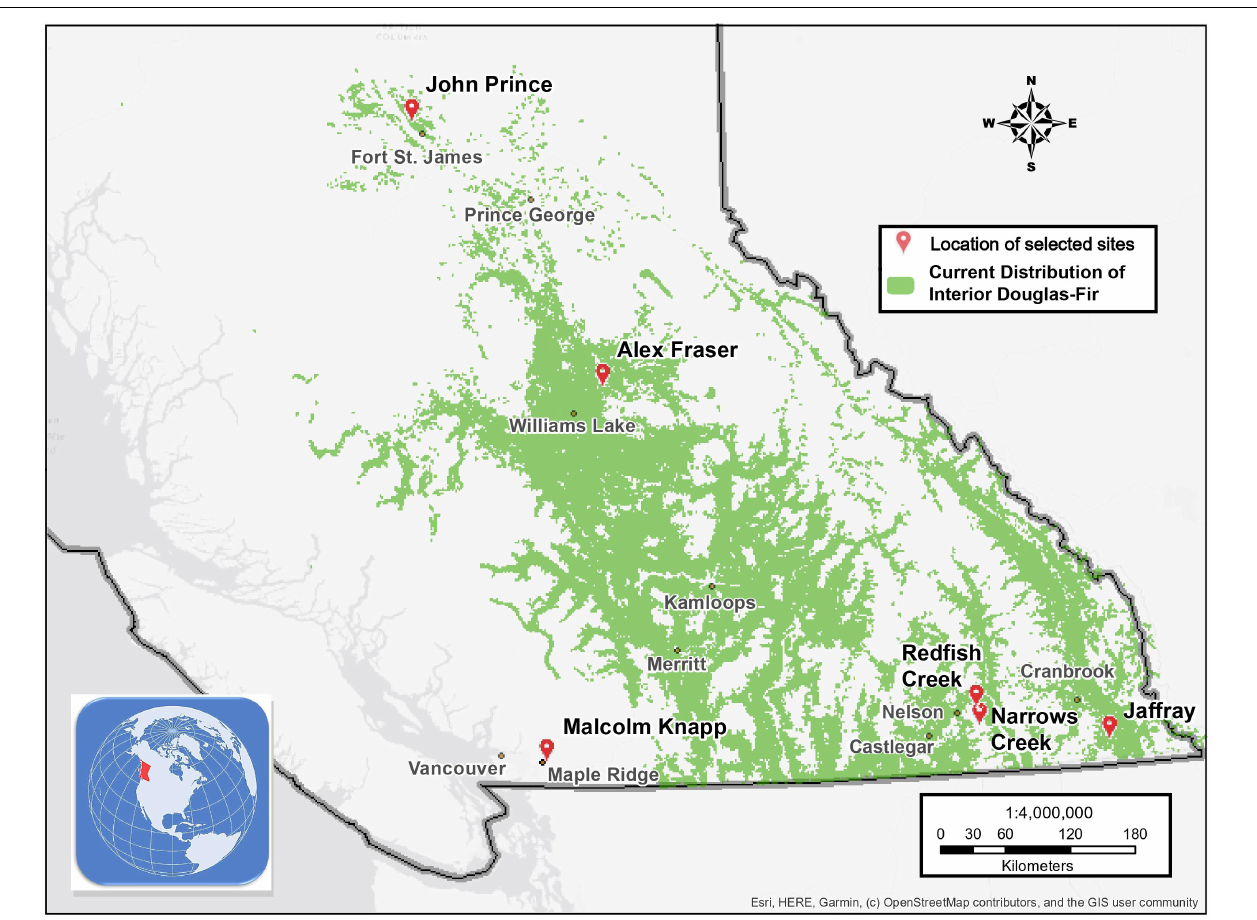
FIGURE 1 | Map of the six research locations and the current distribution of interior Douglas-fir in British